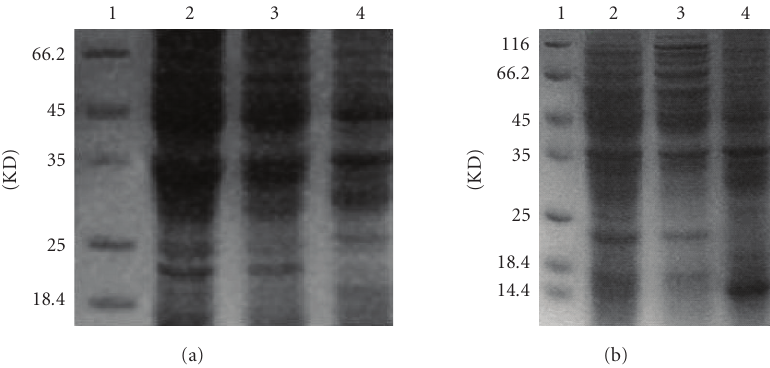
Figure 4: Overexpression of the recombinant concatemer protein. (a) Lane 1: prestained molecular mass markers. Lanes 2 and 3: full bacterial protein from 100 μ L transformed cells after 1.0 mM and 0.5mM IPTG induction for 8 hours at 37 ◦ C. Lane 4: full bacterial protein from 100 μ L transformed cells without induction of IPTG for 8 hours at 37 ◦ C. (b) Lane 1: prestained molecular mass markers. Lane 2: full bacterial protein from 100 μ L transformed cells after 1.0 mM IPTG induction for 8 hours. Lane 3: sedimented material from Sonication of 100 μ L transformed cells after induction with IPTG. Lane 4: suspended material from Sonication of 100 μ L transformed cells after induction with IPTG.